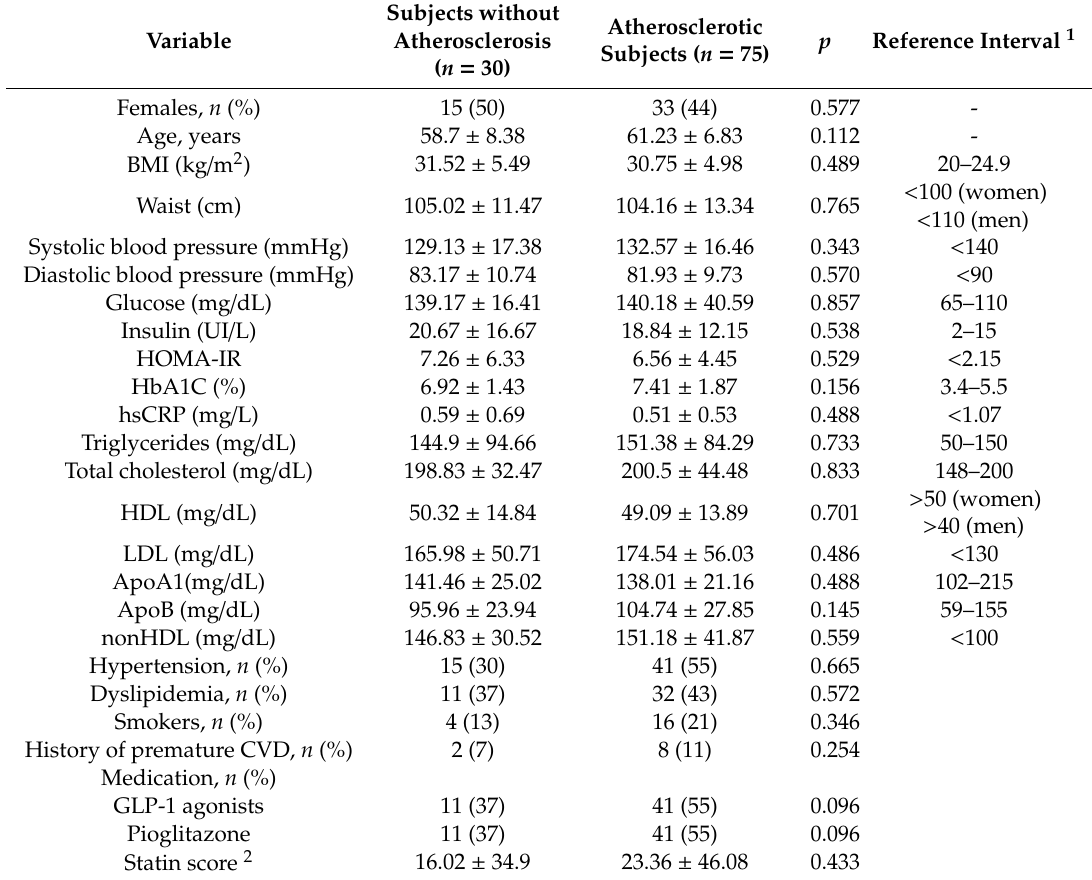
Table 1. Clinical characteristics of the 105 participants with diabetes included in the study.